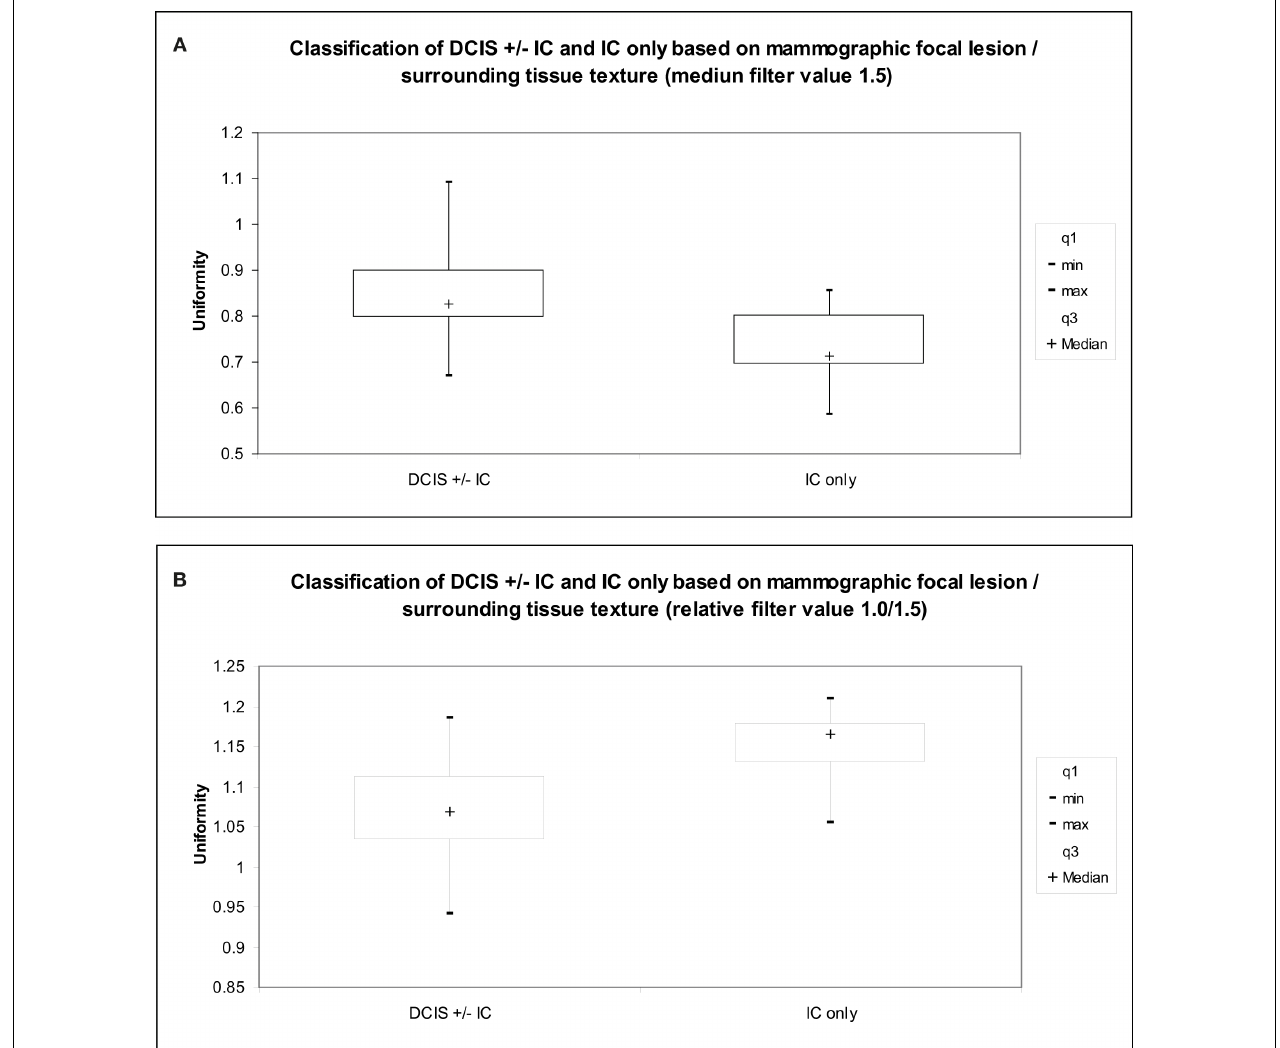
FIGURE 5 | Graph indicates the relationship between (A) medium texture (uniformity), (B) fine to medium texture ratio (uniformity) and extent of disease (tumor type) for the mammographic focal lesion/surrounding tissue